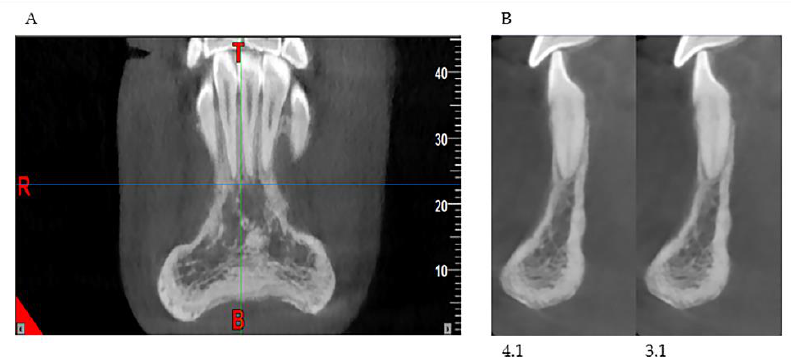
Figure 9. Hourglass-looking chin in the coronal reconstruction ( A ); ( B ) the paraxial image shows the accentuated chin protuberance at the lower end of the symphysis, with thinned cortical.